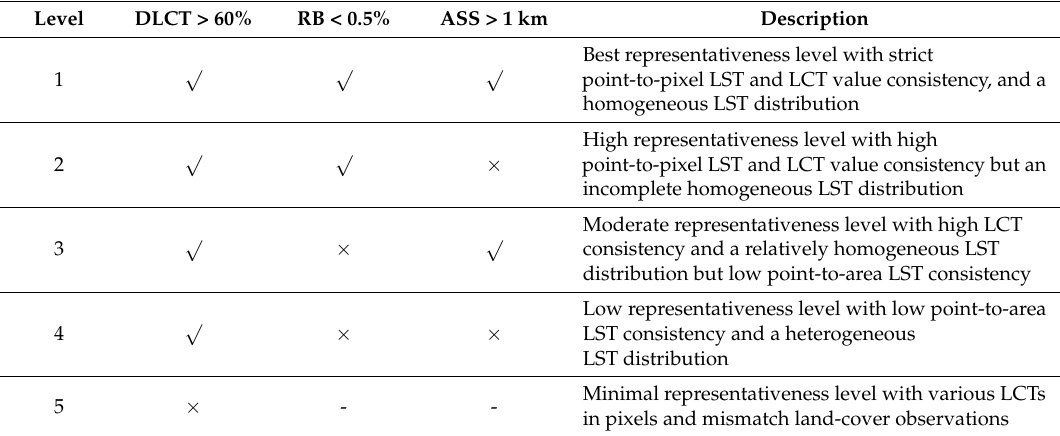
Table 2. Grading of the spatial representativeness.